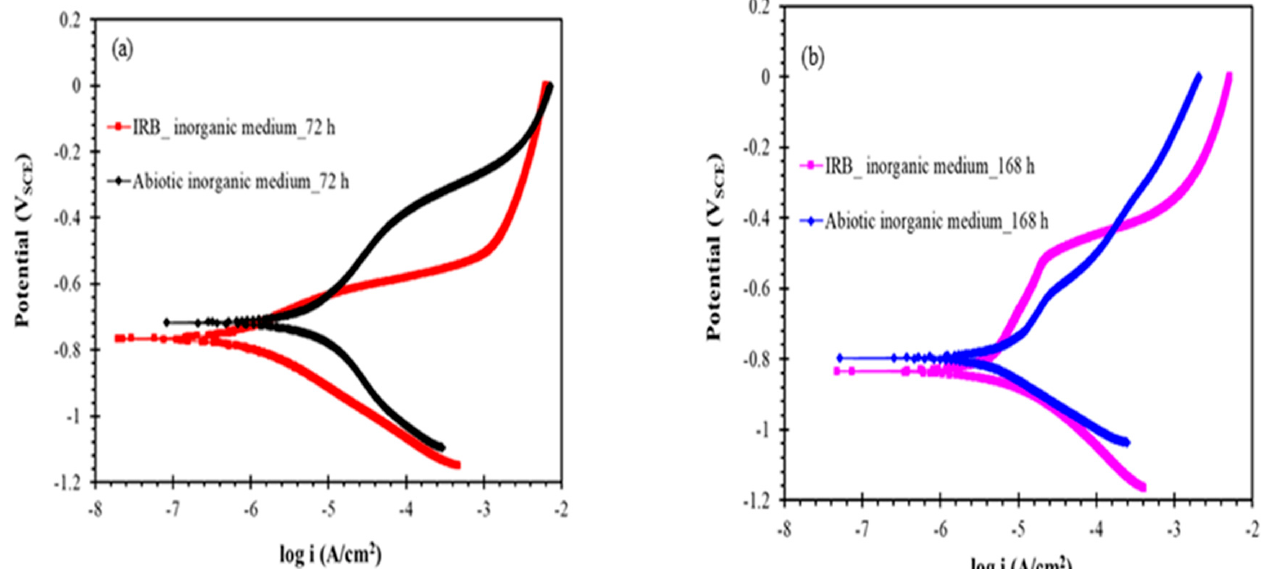
Figure 16. ( a , b ) Potentiodynamic polarization scans of carbon steel following 72 and 168 h exposure, with and without the IRB, to inorganic Postgate C solution.